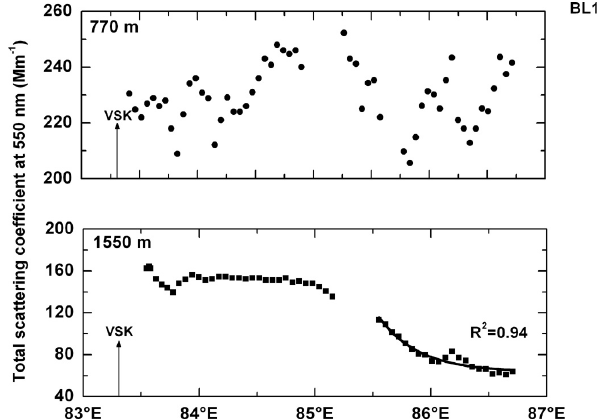
Fig. 6. Longitudinal variation of σ tsc at 770 (upper panel) and 1550m (lower panel) altitude off-VSK during BL1 over 17.7 ◦ N latitude. Solid line indicates the best exponential decay function be- yond 85 ◦ E. The arrows in both the panels represent the longitude of VSK airport.